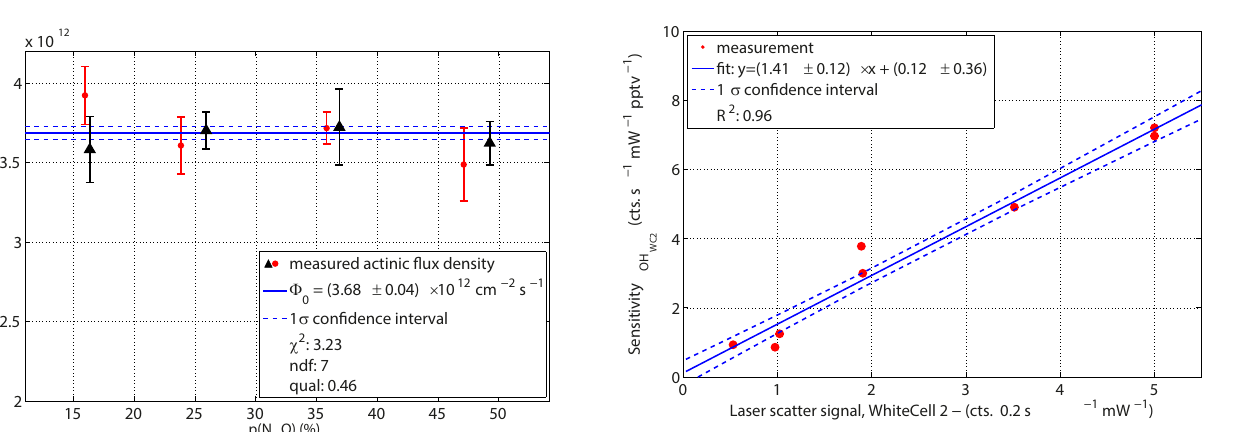
Figure 1. Actinic flux density of the mercury lamp used for cali- bration of the HORUS instrument. The actinic flux density 8 0 is derived from the photolysis of N 2 O at different mixing ratios and the subsequent detection of the NO yields. The data shown here is the combined data set from two actinometric measurements, one of them conducted before (red dots) and a second one after (black triangles) the field campaign, indicating a good long-term stability of the lamp actinic flux density. Error bars indicate the propagated statistical variability of the calculated flux density.